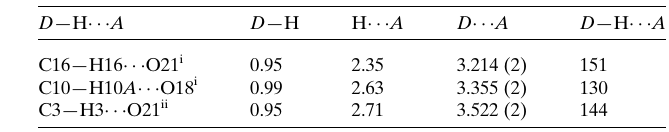
Table 1 Hydrogen-bond geometry (A˚ , (cid:2) ).